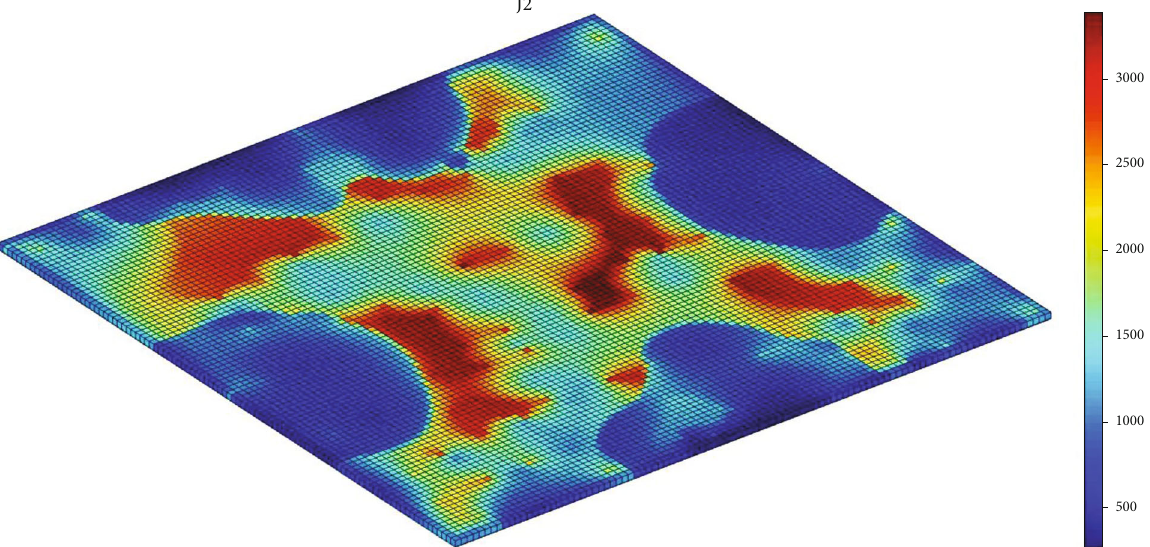
Figure 8: The productivity potential of the original